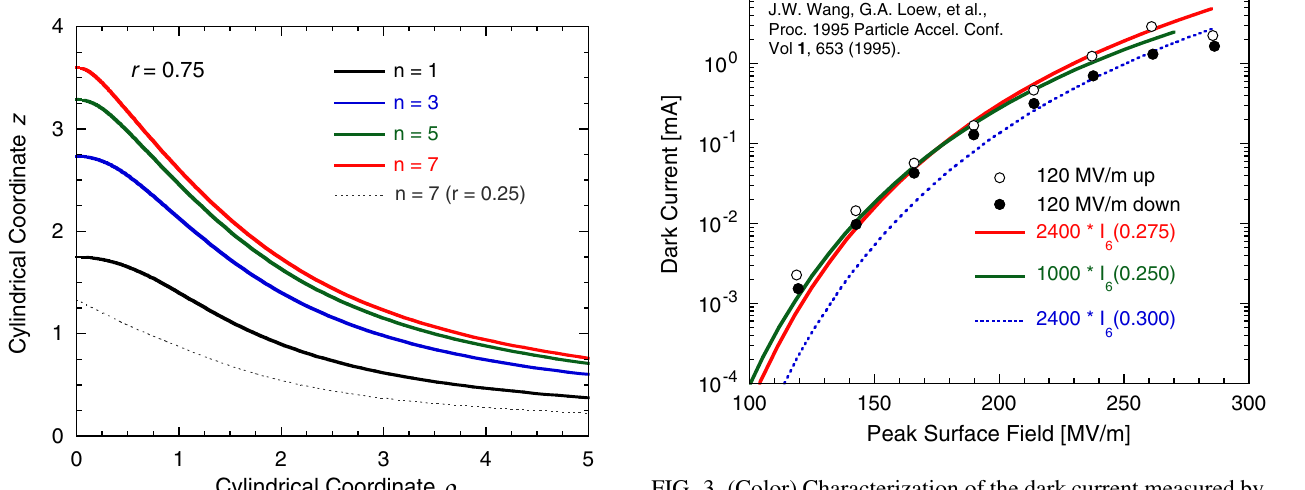
FIG. 3. (Color) Characterization of the dark current measured by Wang and Loew in Ref. [41] with the point-charge model. The red, blue, and green theory lines are identified by the nomen- (cid:3) r (cid:4) , where N acts as the number of emitters, I clature NI n indicates current, and r is the ratio factor.